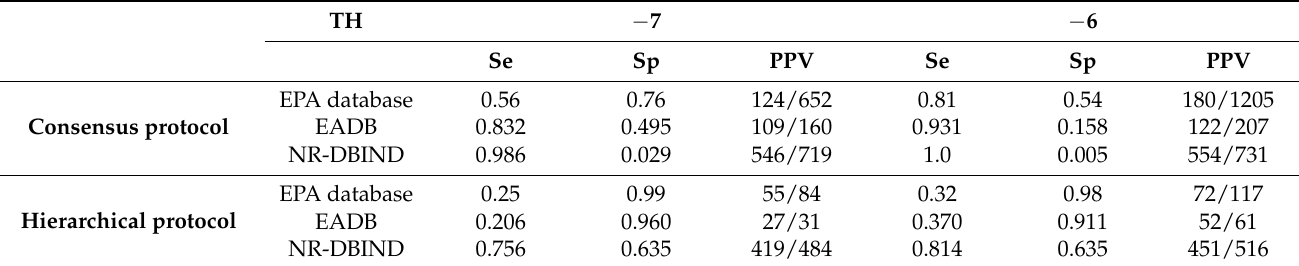
Table 5. Sensitivities (Se), specificities (Sp), and B/Total ratio calculated for the consensus and hierarchical screening method for two different thresholds (TH) of docking